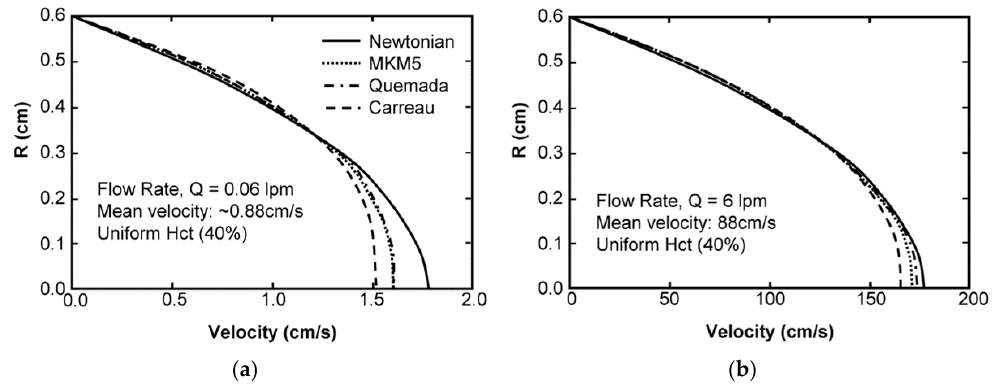
Figure 5. The effect of fibrinogen concentration on the viscosity of 45% canine blood at a temperature of 37 °C. Comparison of experimental data from Chien [23] with the modified Krieger model.